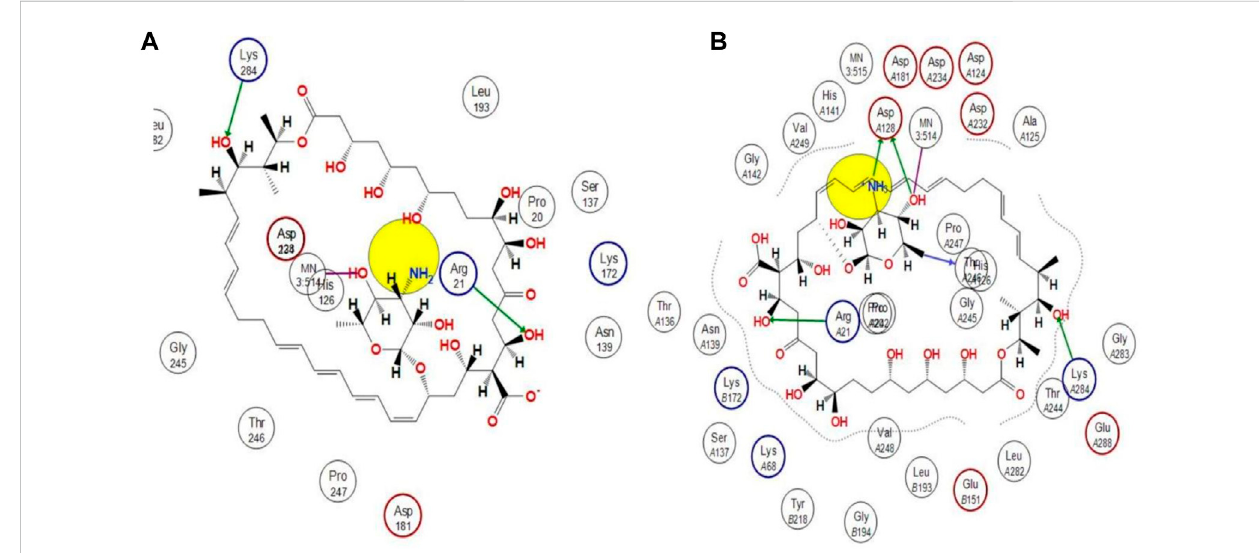
FIGURE 11 Representation of the 2D interactions of the (A) protonated ZINC000252286875 and (B) Non-Protonated ZINC000252286875 ligand with the arginase-1 protein